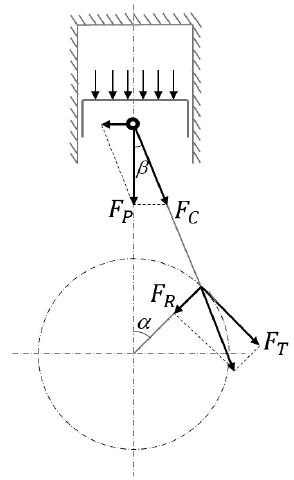
Figure 9. The force transmitting through the conrod.